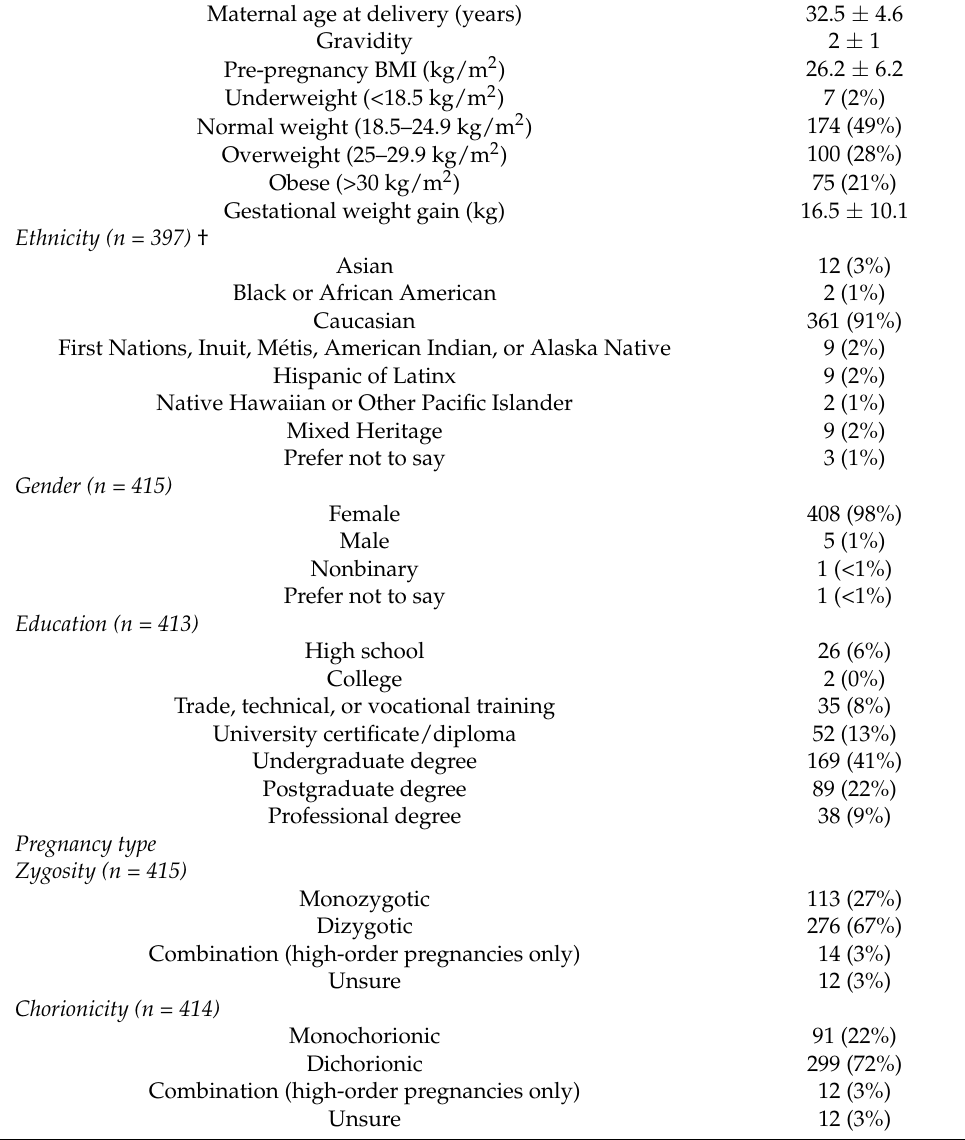
Table 1. Participant demographics. Data presented as mean ± SD or n